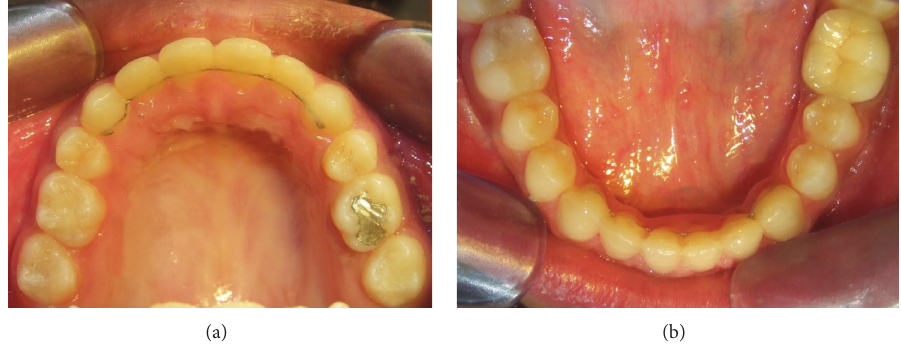
Figure 19: Posttreatment: (a) Upper, and (b) lower